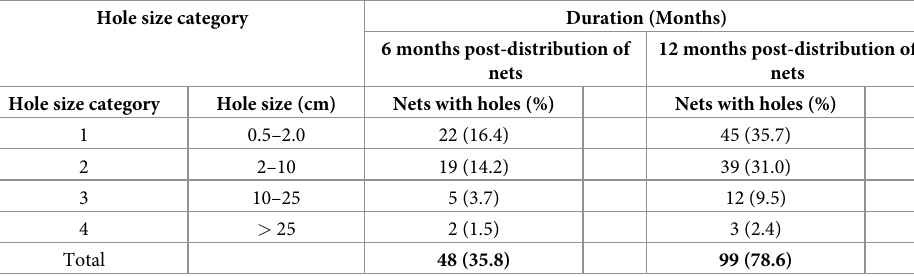
Table 4. Physical integrity of LLINs with holes of different size categories.